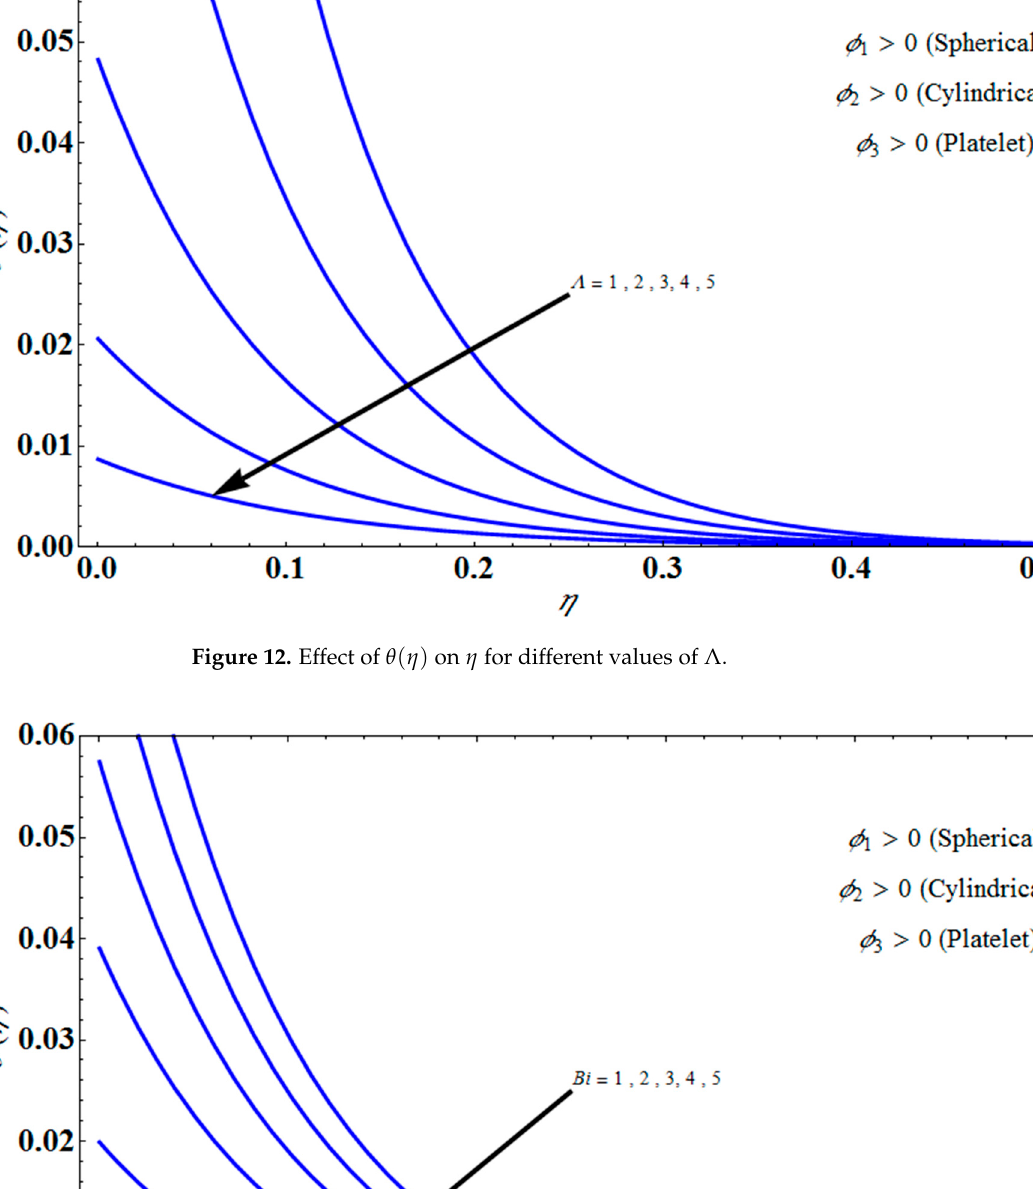
Figure 13. Influence of θ ( η ) on η for different values of Bi